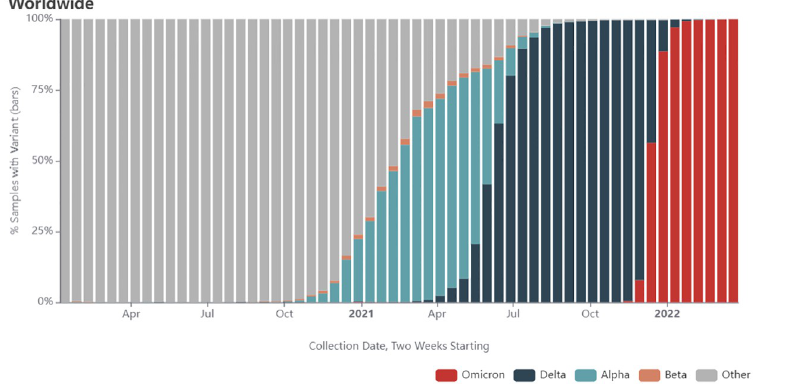
Fig 1. SARS-CoV-2 variants distribution